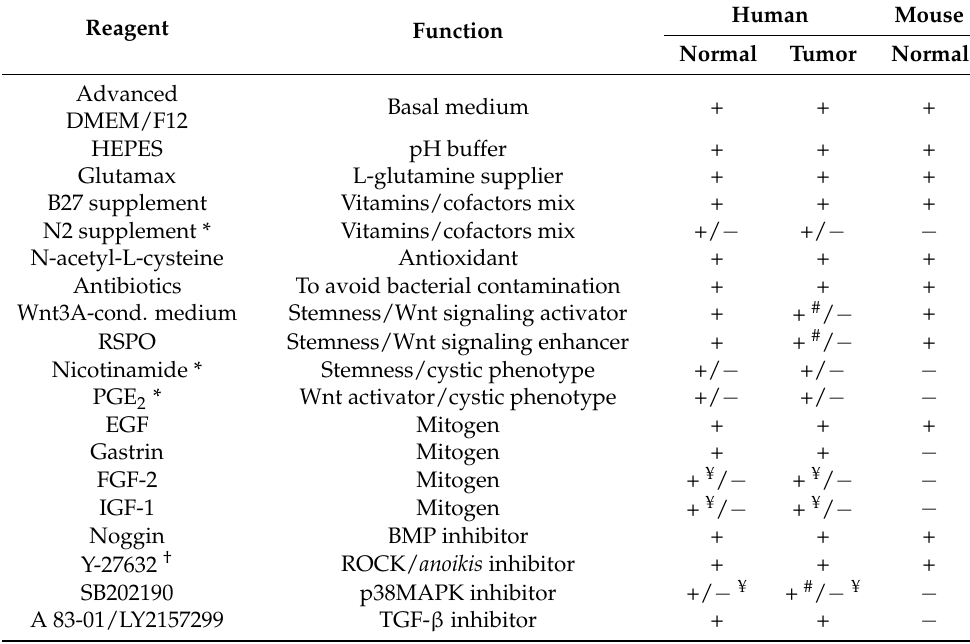
Table 1. Composition of growth medium for human and mouse organoid